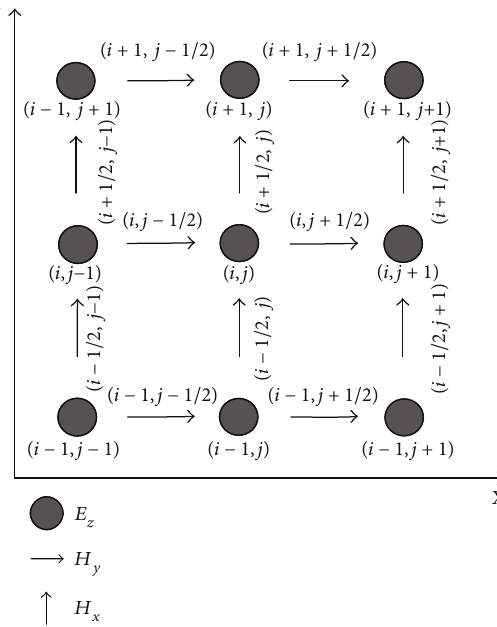
Figure 1: Indices notation for the considered